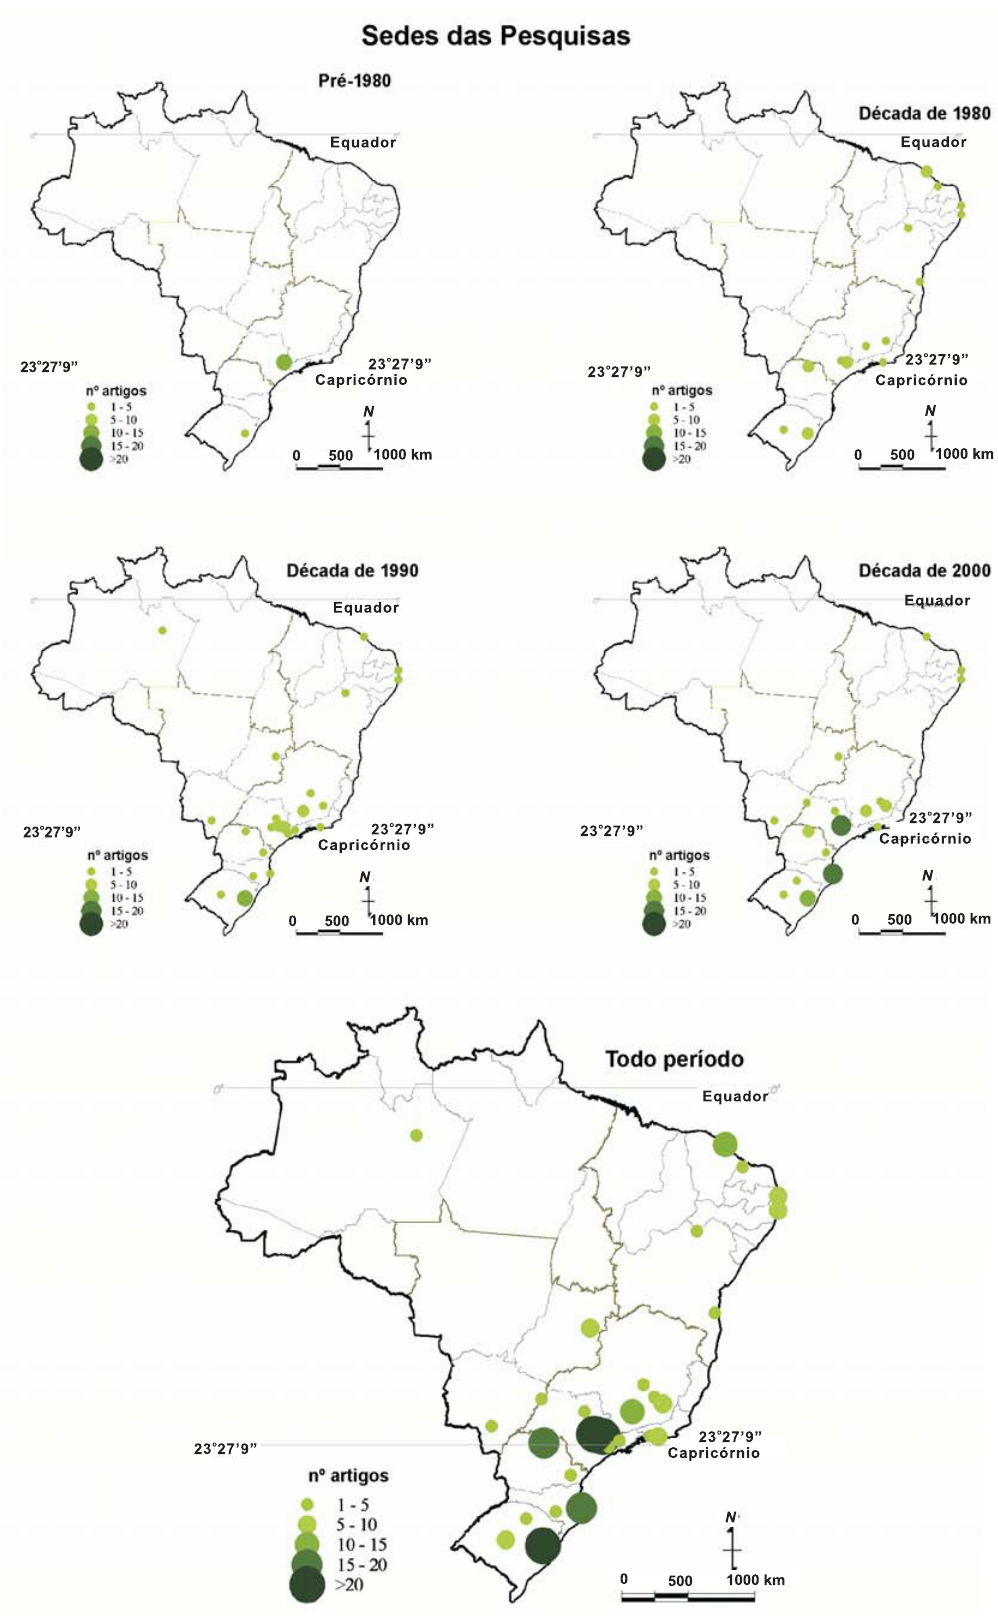
Figura 4. Sedes das pesquisas que resultaram em artigos publicados sobre erosão do solo no